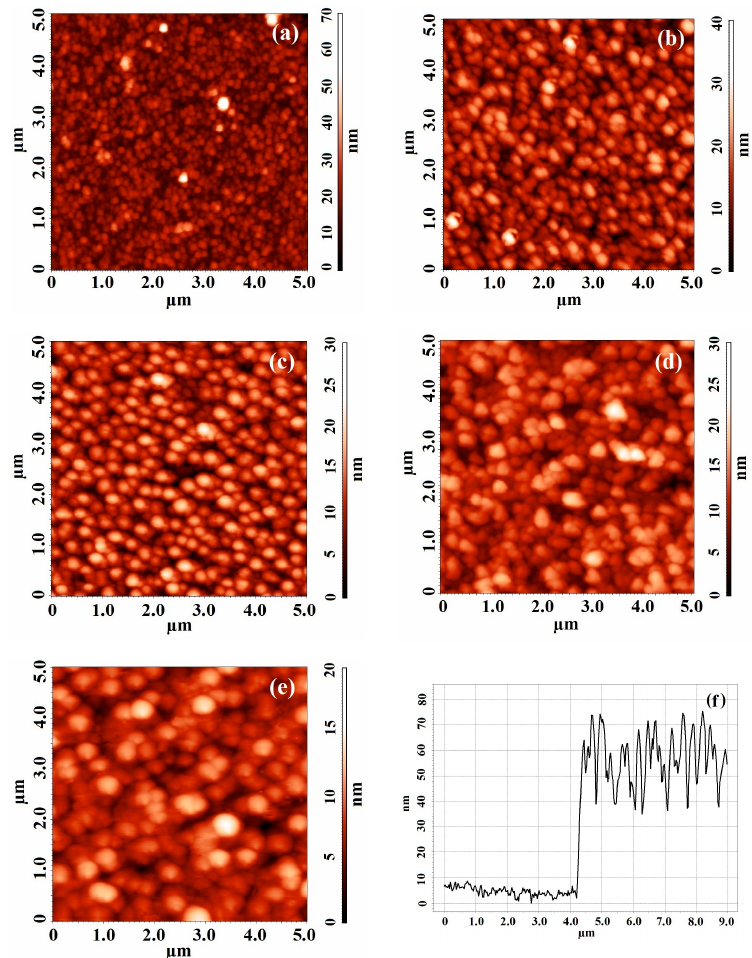
Figure 1. AFM images of nanocrystalline ZnO films fabricated at various annealing temperatures: ( a )—without annealing (25 °C); ( b )—600 °C; ( c )—800 °C; ( d )—1000 °C; ( e )—1200 °C, and ( f )—AFM cross-section of the ZnO/Al 2 O 3 interface before annealing.